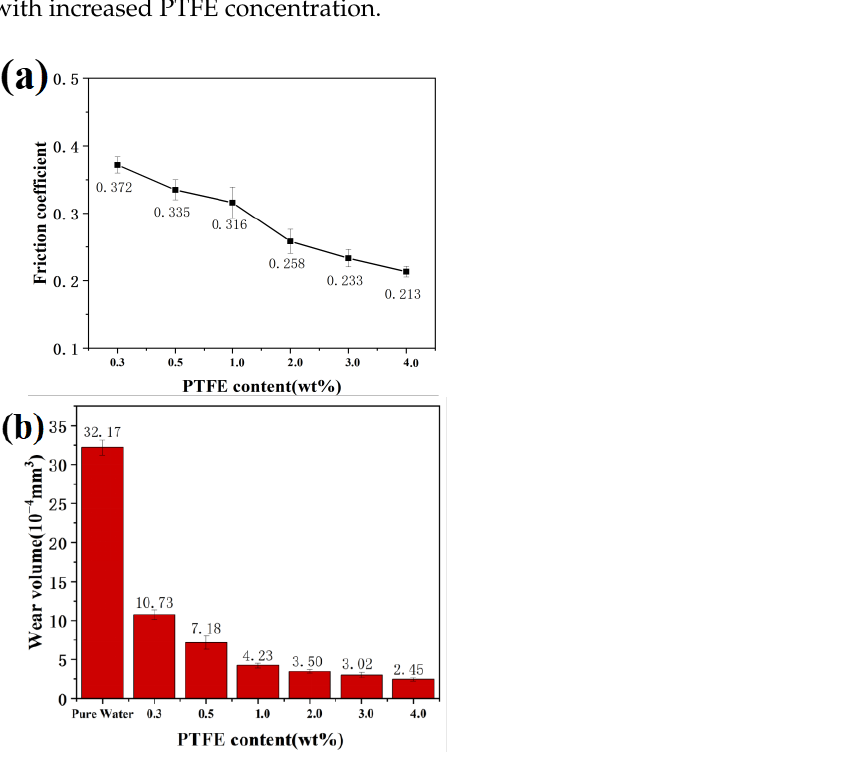
Figure 7. ( a ) The friction coefficient and ( b ) wear volume of PTFE/PS with different content of PTFE.